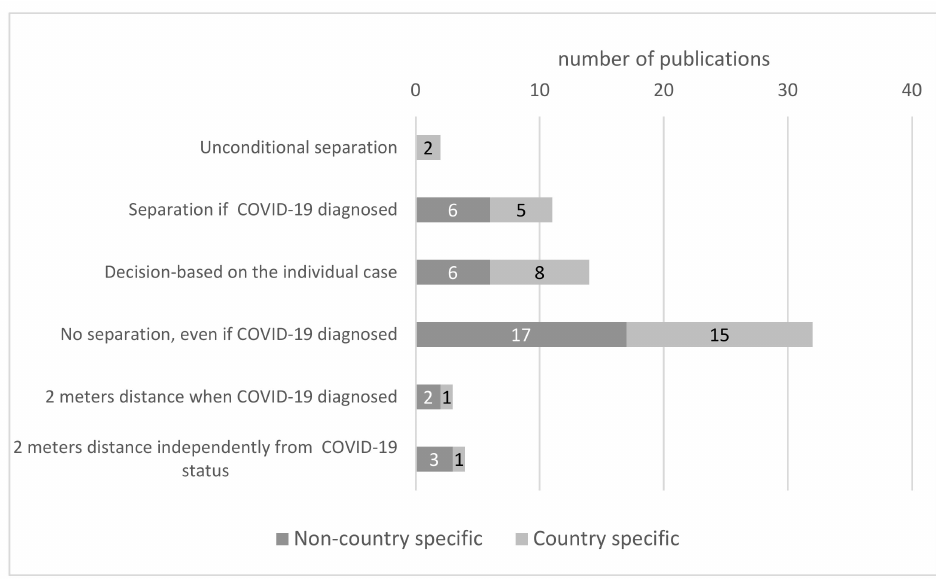
Figure 5. Recommendations concerning rooming-in management for mothers with confirmed and/or suspected